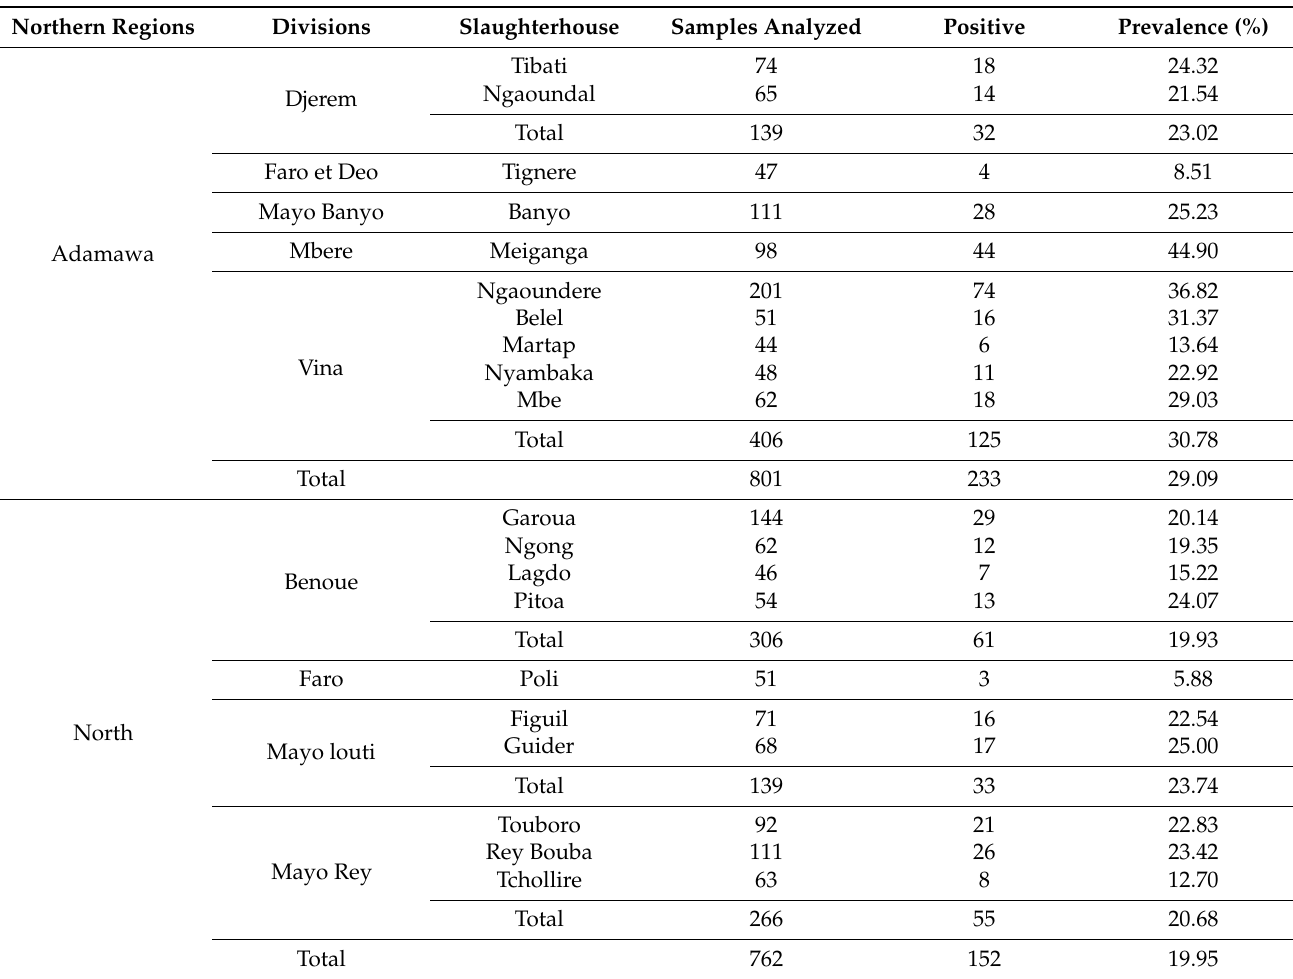
Table 2. Seroprevalence of C. burnetii for each slaughterhouse in northern regions of Cameroon ( n =